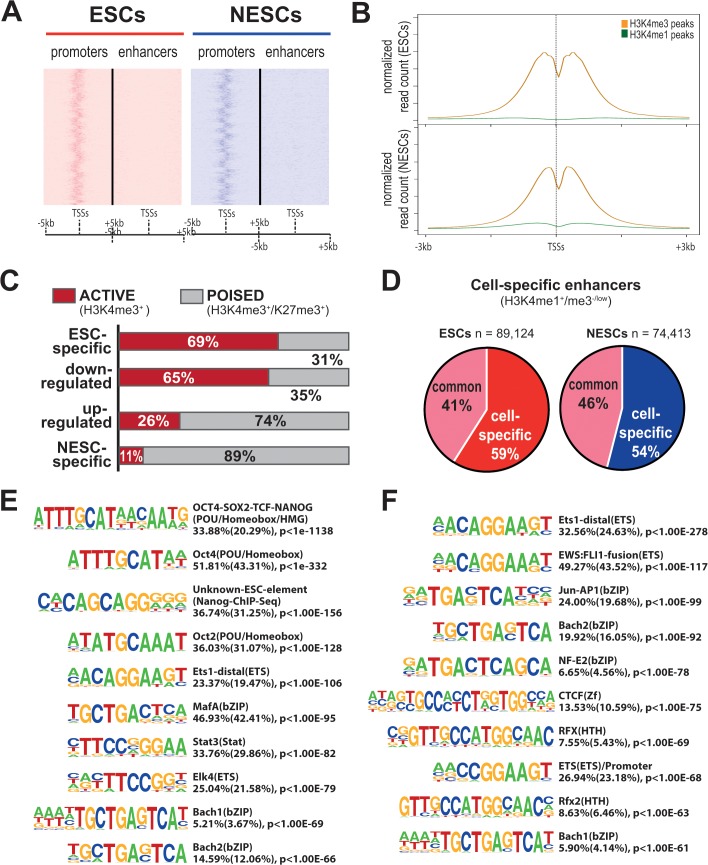
Genome-wide mapping of epigenetically-defined promoters and enhancers in ESCs and NESCs.A) Heat maps showing the distribution of promoter (left) and enhancer (right) regions in a window of ±5-kb from CAGE-mapped TSSs in ESCs and NESCs. Promoter islands are defined as H3K4me3+/high/me1-/low, enhancers as H3K4me1+/high/me3-/low. Promoter islands are clustered around CAGE-mapped TSSs, whereas enhancers are spread out. B) Average profile of single H3K4me3 (orange) and H3K4me1 (green) peaks around the TSS, in a ±3-kb. Normalized read count means histone modification read count per million mapped reads. C) Epigenetic state of CAGE promoters in ESCs. The histogram shows the fraction of ESC-specific, down-regulated, up-regulated and NESC-specific promoters with the epigenetic signature of active (H3K4me3+, red) or poised (H3K4me3+/H3K27me3+, grey) promoter. The most part of up-regulated and NESC-specific promoters are poised for transcription in ESCs. D) Pie-diagrams showing the fraction of common and cell-specific total enhancers mapped in ESCs and NESCs. E) Analysis of putative TFBS enrichment within cell-specific enhancers as determined by HOMER tool. ESC-specific enhancers showed enrichment of binding motifs for the pluripotency TFs, as observed for cell-specific promoters, and for ETS family factors. NESC-specific enhancers were enriched for ETS-family, RFX-family and Jun/AP1 factors.